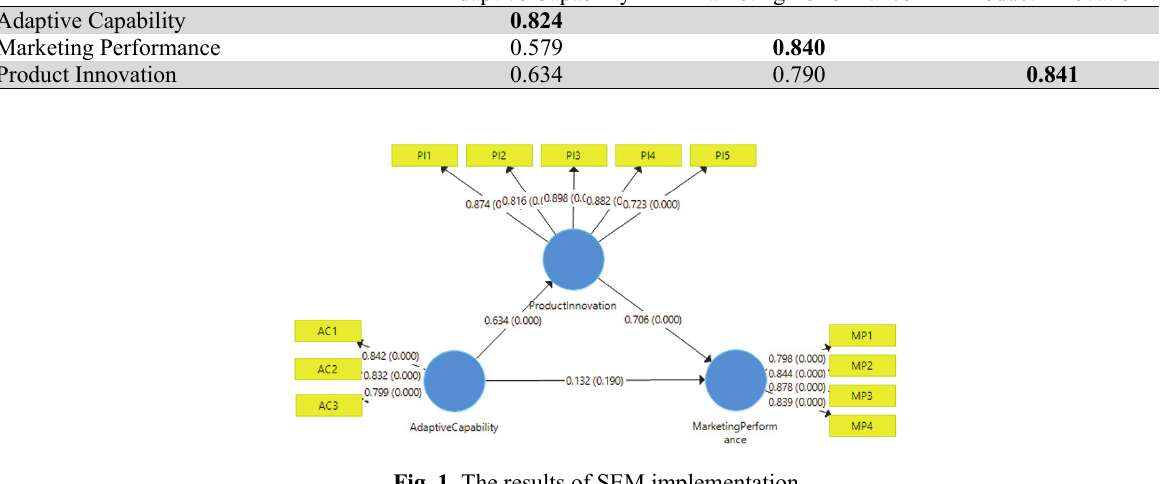
Fig. 1. The results of SEM